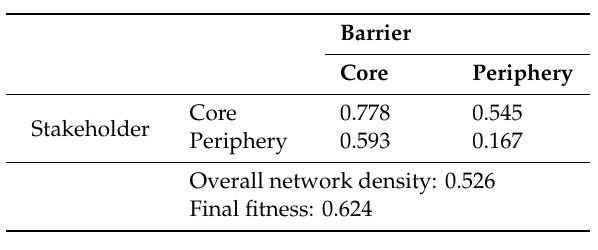
Table 3. Density matrix.